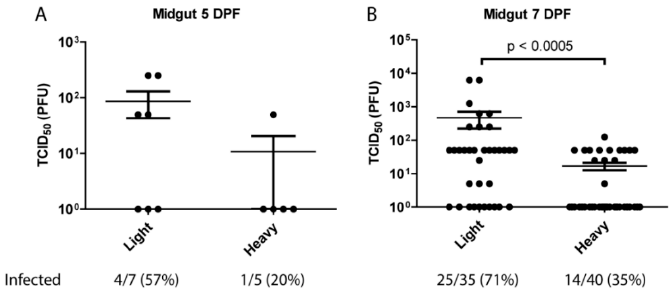
Figure 2. Analysis of particle infectivity in mosquitoes following blood meal. Five to seven-day old female mosquitoes were fed rabbit blood supplemented 1:4 with 1 × 10 8 particles of either light or heavy SINVMRE3’2J-GFP. Midguts were dissected at ( A ) 5 days or ( B ) 7-days post-infection and virus quantified by TCID 50 on Vero cells. P values were calculated by Mann–Whitney test. All error bars represent standard error of mean (SEM).